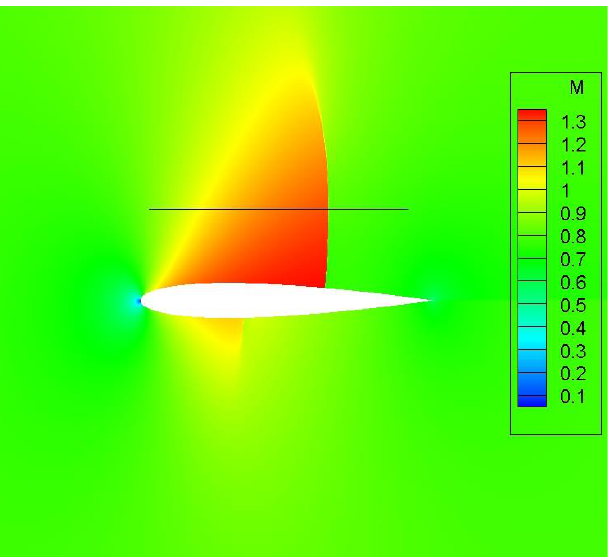
Figure 10. Mach contours and cutting line for flow past a NACA0012 airfoil at M = 0.8 and α = 1.25°. Contour plots of the adjoint variables are shown in Figures 11 and 12. Notice that the adjoint solution is singular along the incoming stagnation streamline [5,21], the wall [21], and also along a delta-like structure formed by the supersonic characteristic emanating from the shock foot and its reflection off the sonic line [22], but it is continuous across the shock and the sonic line. A zoom of the adjoint solution near the upper shock (Figure 12) shows that the adjoint derivatives are actually discontinuous (notice the abrupt change of direction of the adjoint contour lines of the y-momentum adjoint variable